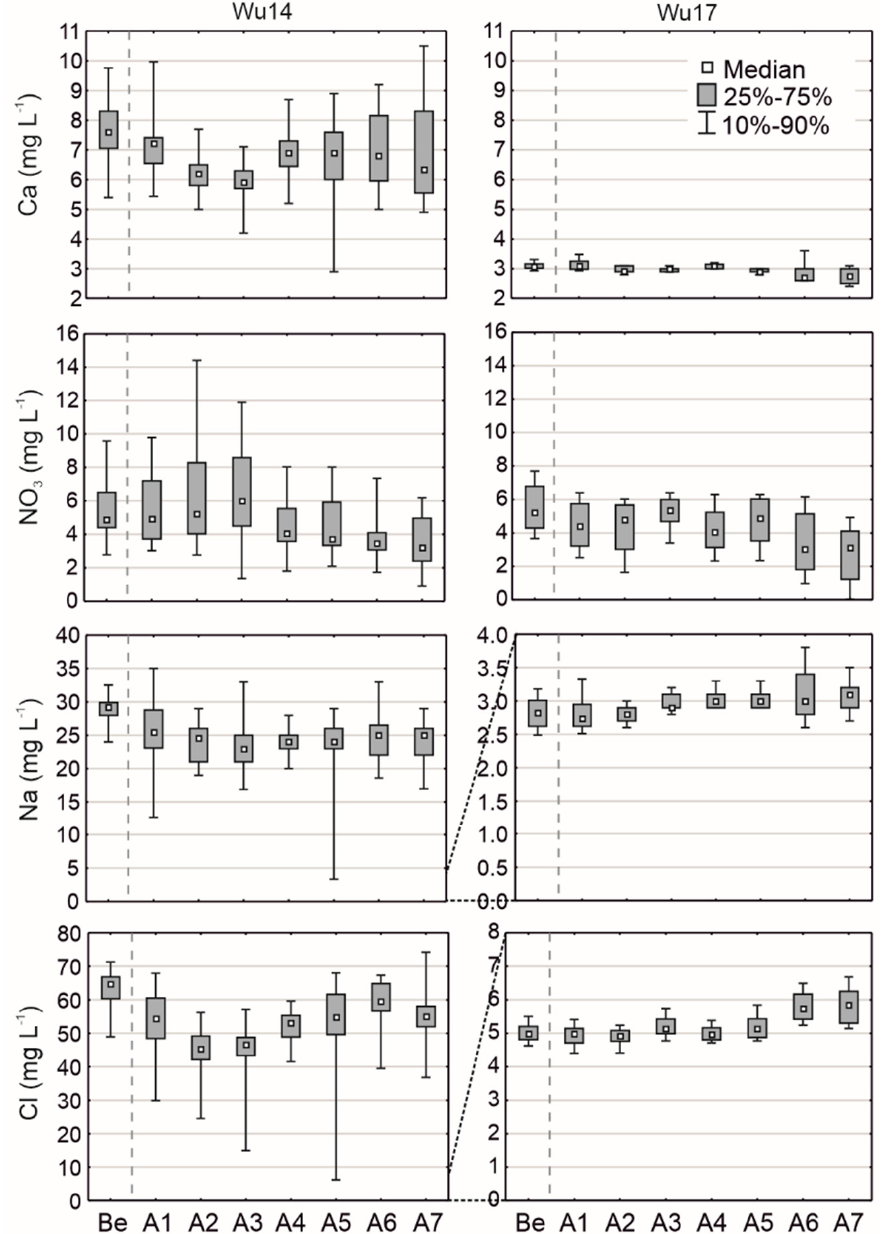
Figure 7. Concentrations of selected ions (Ca 2+ , Na + , NO 3 − and Cl − ) in the post-deforestation period (A1–A7) compared to the pre-deforestation period (Be) in the partially deforested Wüstebach catchment (Wu14) and the control catchment (Wu17).